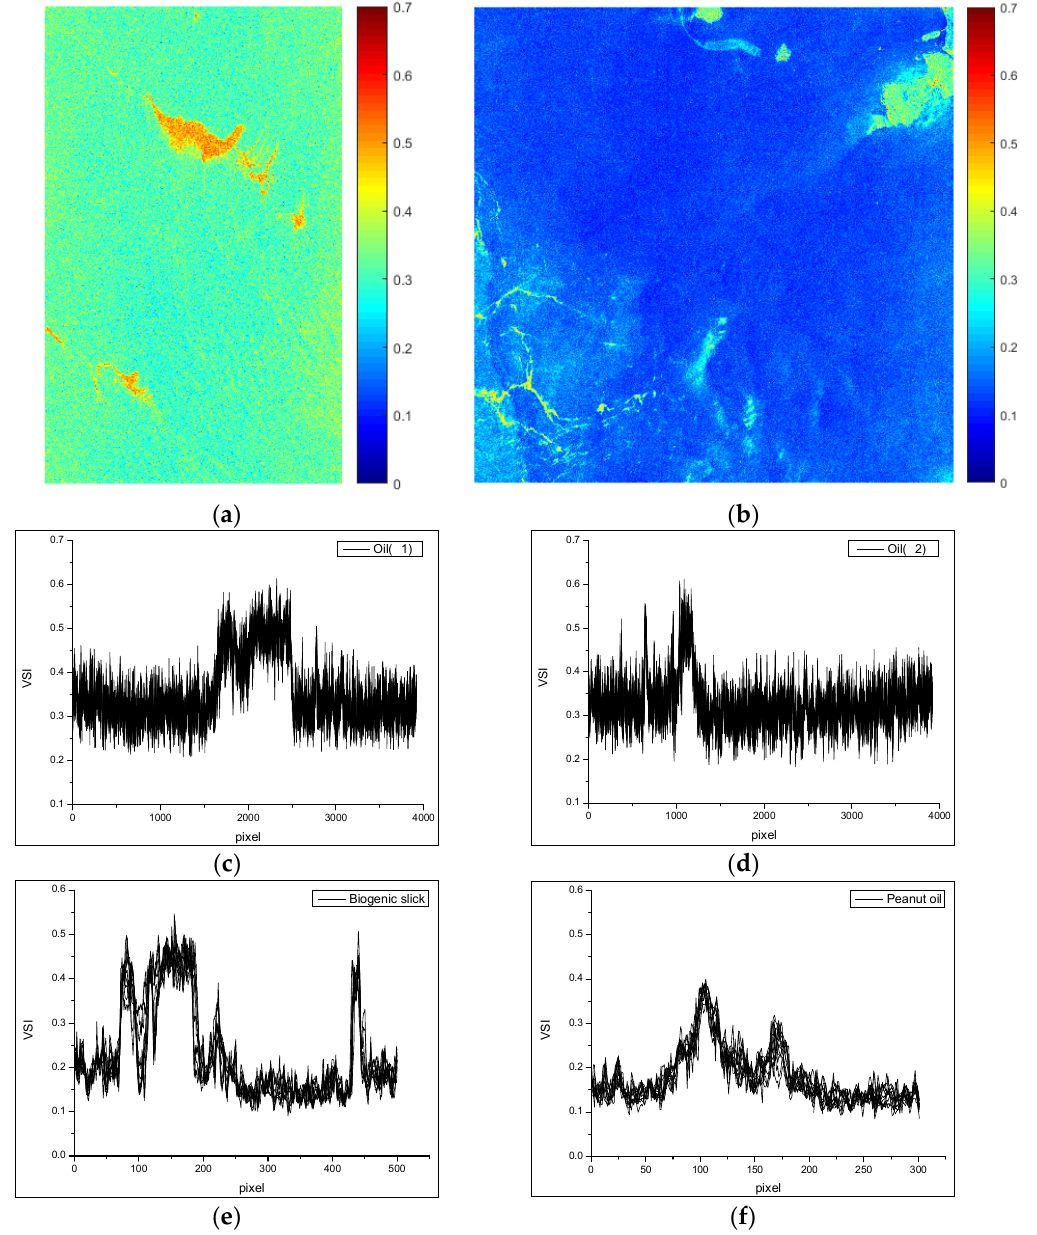
Figure 12. Volume Scattering Index (VSI) values for the two continuously slow-release slicks cases mentioned above: ( a ) Case 1; ( b ) Case 2; ( c – f ) VSI for the four green rectangular areas (oil (1), oil (2), biogenic slick, and peanut oil, respectively) that are indicated on the SAR images in Figures 2 and 3.